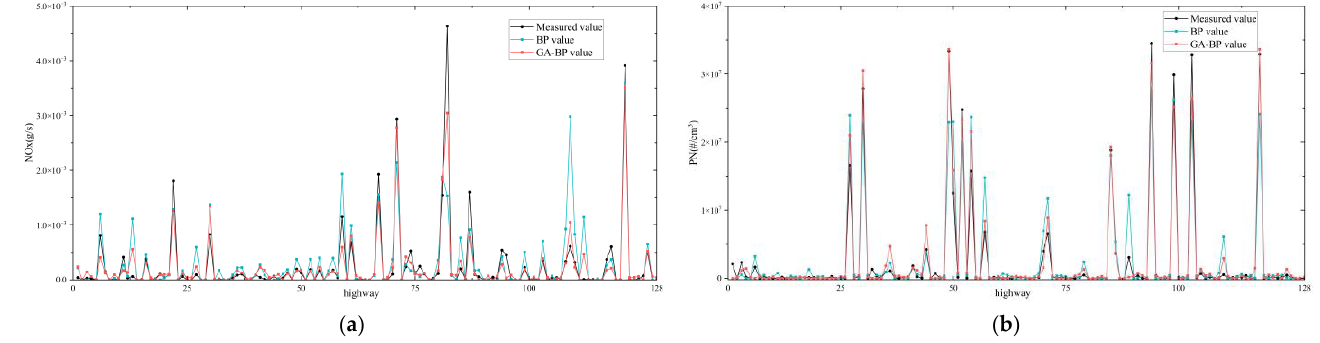
Figure 10. Comparison of the predicted results of BP and GA-BP for NOx and PN in highway areas with the measured values. ( a ) Highway NOx; ( b ) highway PN.